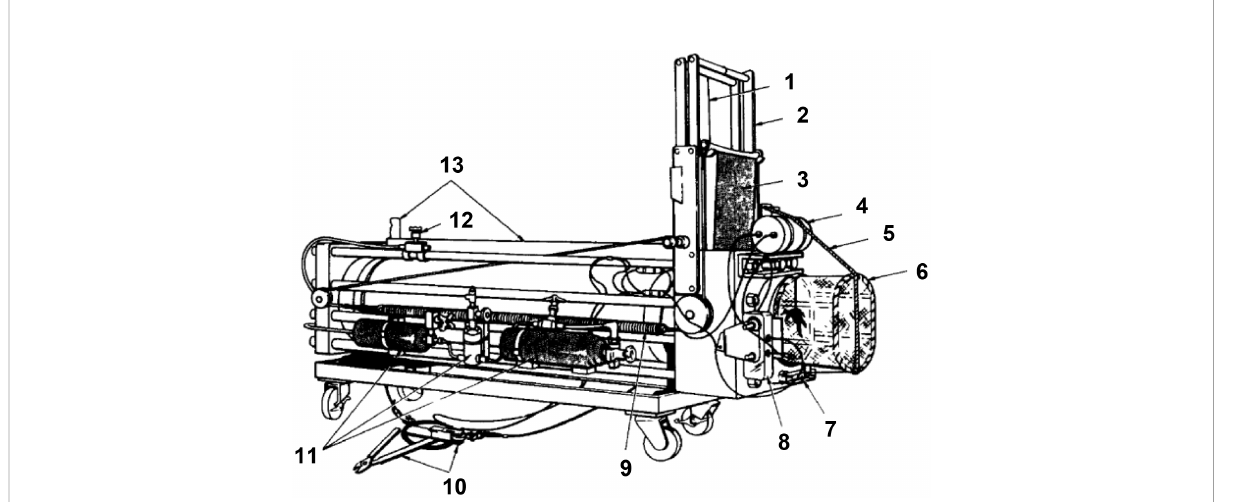
FIGURE 6 Schematic diagram of hyperbaric trap-aquarium (1:Pressure gauges; 2:Window; 3:Plexiglass; 4:Negator spring(pulls fi sh in- and closes door after tugging fi sh releases ballast); 5:Main AI tube; 6:Line between negator spring and fi sh hook; 7:Line to pin; 8:Large AI tube; 9:Pin; 10:Shock cords